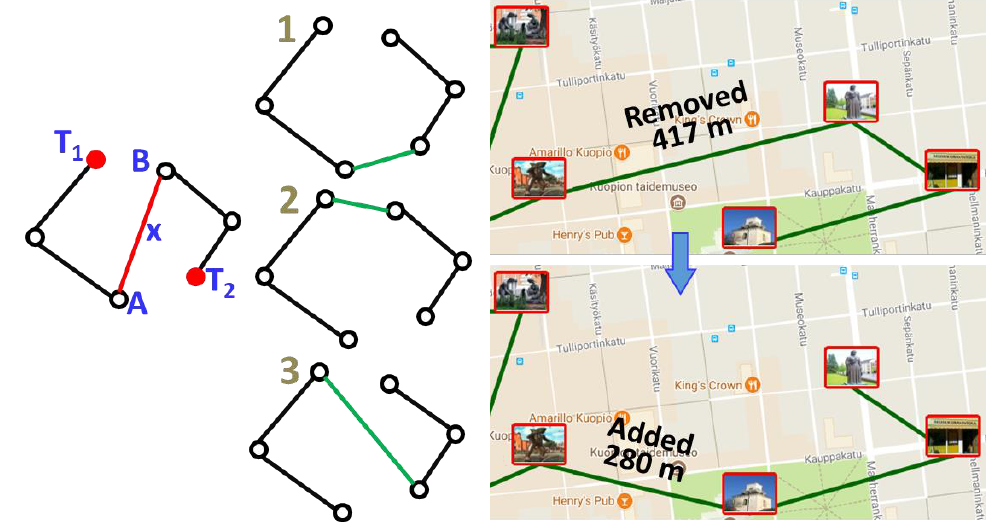
Figure 7. Original tour and three alternatives created by link swap (left). In each case, the link x is replaced by a new link connecting to one or both terminal nodes. In the O–Mopsi example (right), the tour is improved by 137m.